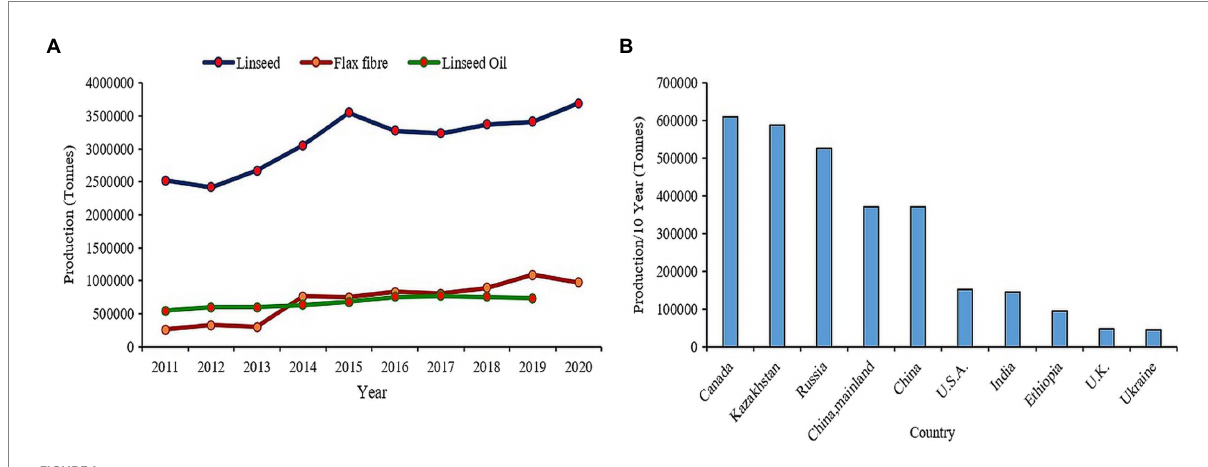
FIGURE 1 (A) Trends in global production of linseed and flax fiber in past decade. (B) Flaxseed production in top 10 countries in the